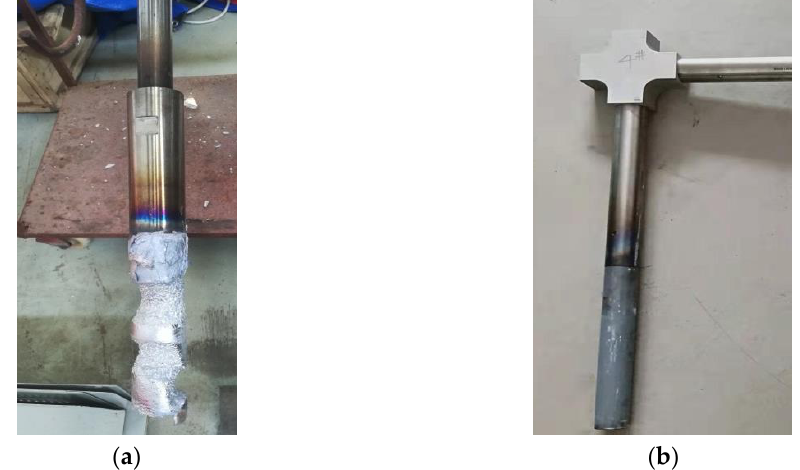
Figure 4. Morphology of sonotrodes: ( a ) straight-rod titanium alloy sonotrode; ( b ) L-shaped ceramic sonotrode.